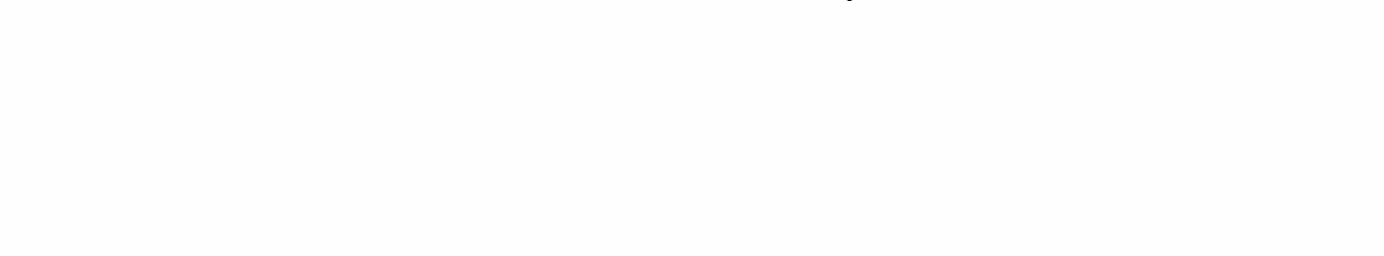
FIGURE 3 Projection of the Lorenz attractor on the plane (x, z) (black color) and the basin of its attraction (grey color) in the Poincare section y=0 for r=28, c7= 10,